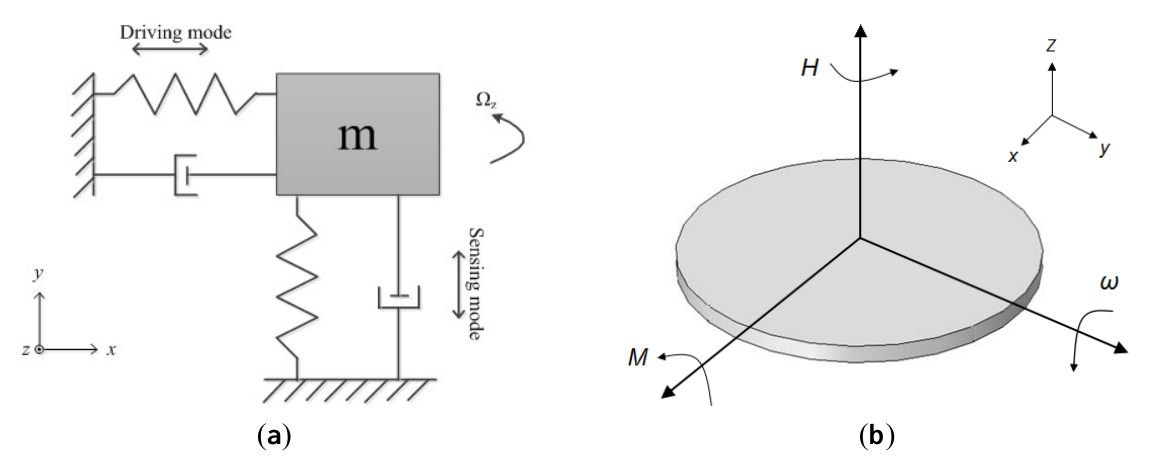
Figure 1. Principles of micromachined gyroscopes. ( a ) Coriolis effect. ( b ) Precession